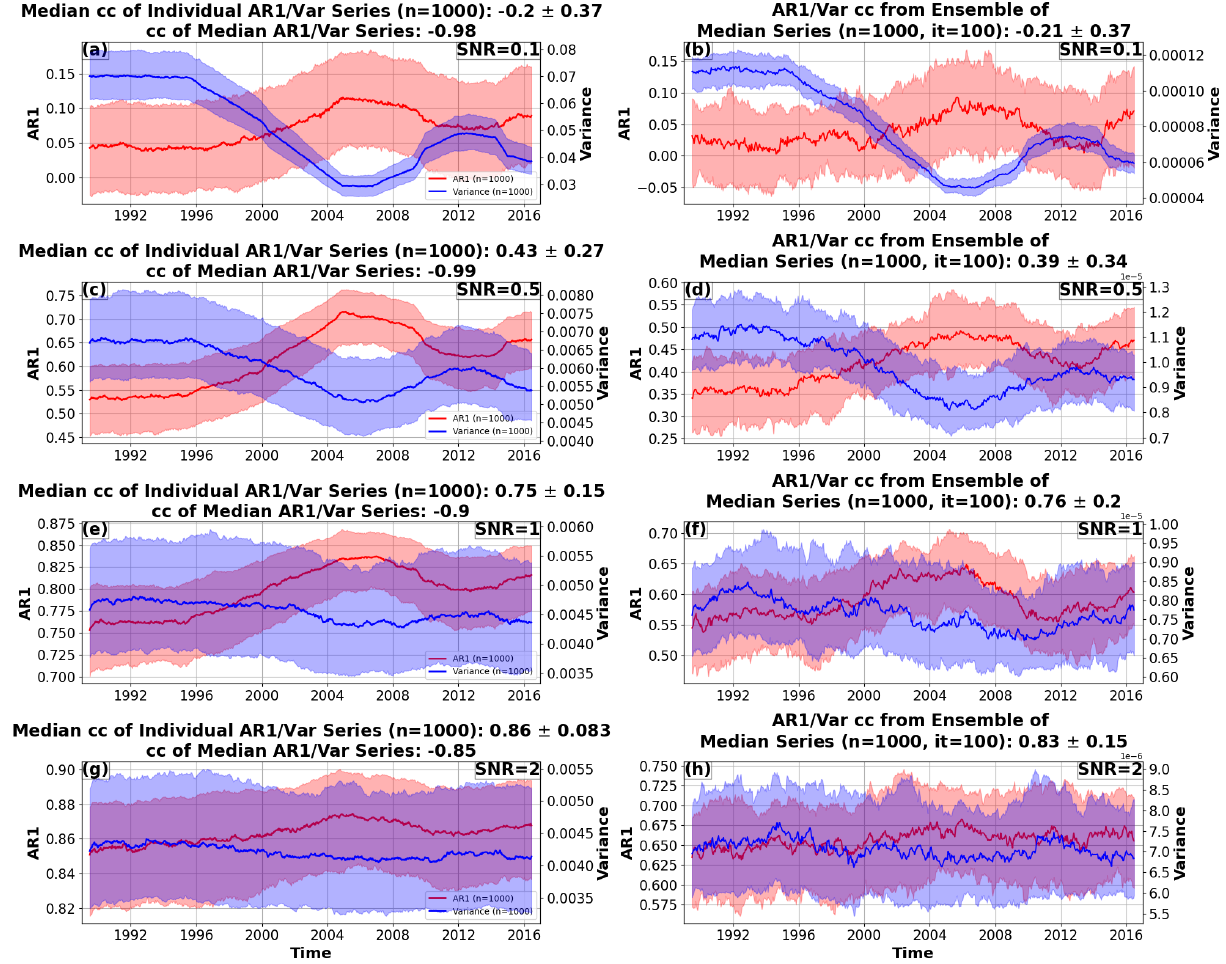
Figure 2. Effect of sensor signal-to-noise ratios (SNRs) and data aggregation scheme. Panels (a) , (c) , (e) , and (g) show median (25th–75th percentiles shaded) AR1 (red) and variance (blue) time series of n = 1000 synthetic time series. Panels (b) , (d) , (f) , and (h) show the median AR1 (red) and variance (blue) time series of 100 iterations, taking the median time series from n = 1000 synthetic time series each time before calculating AR1 and variance. The SNR increases from 0.1 (a, b) to 2 (g, h) , while relative noise levels between satellites ( R satellite ; see Methods) are held constant. Correlation coefficients (cc’s) ± 1 standard deviation listed in plot titles. Low SNRs produce anti-correlated individual AR1 and variance time series, indicating a bias induced by the changing sensor mix. For increasing SNRs, the correlation values between individual AR1 and variance time series become increasingly positive, indicating a weaker bias. The same holds true if the AR1 and variance of the medians of the time series themselves are considered (b, d, f, h) . However, correlations between median AR1 and variance time series remain negative, indicating that the bias persists in this case (a, c, e, g) . AR1 and variance are calculated on a 5-year rolling